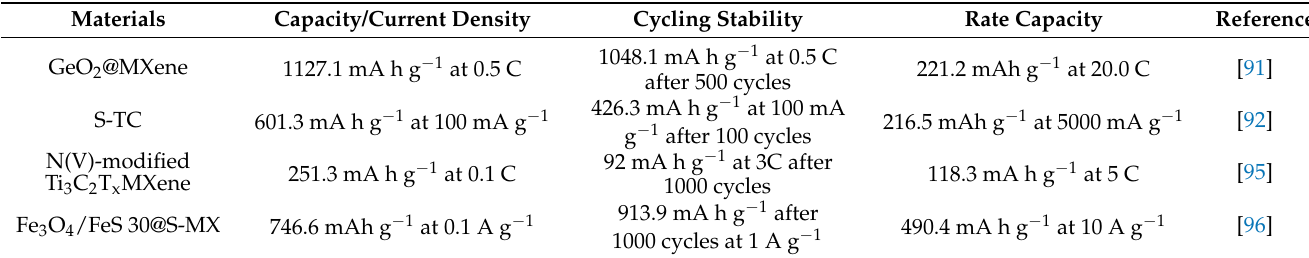
Table 2. Comparison of the electrochemical properties of different MXene-based materials for LIBs.